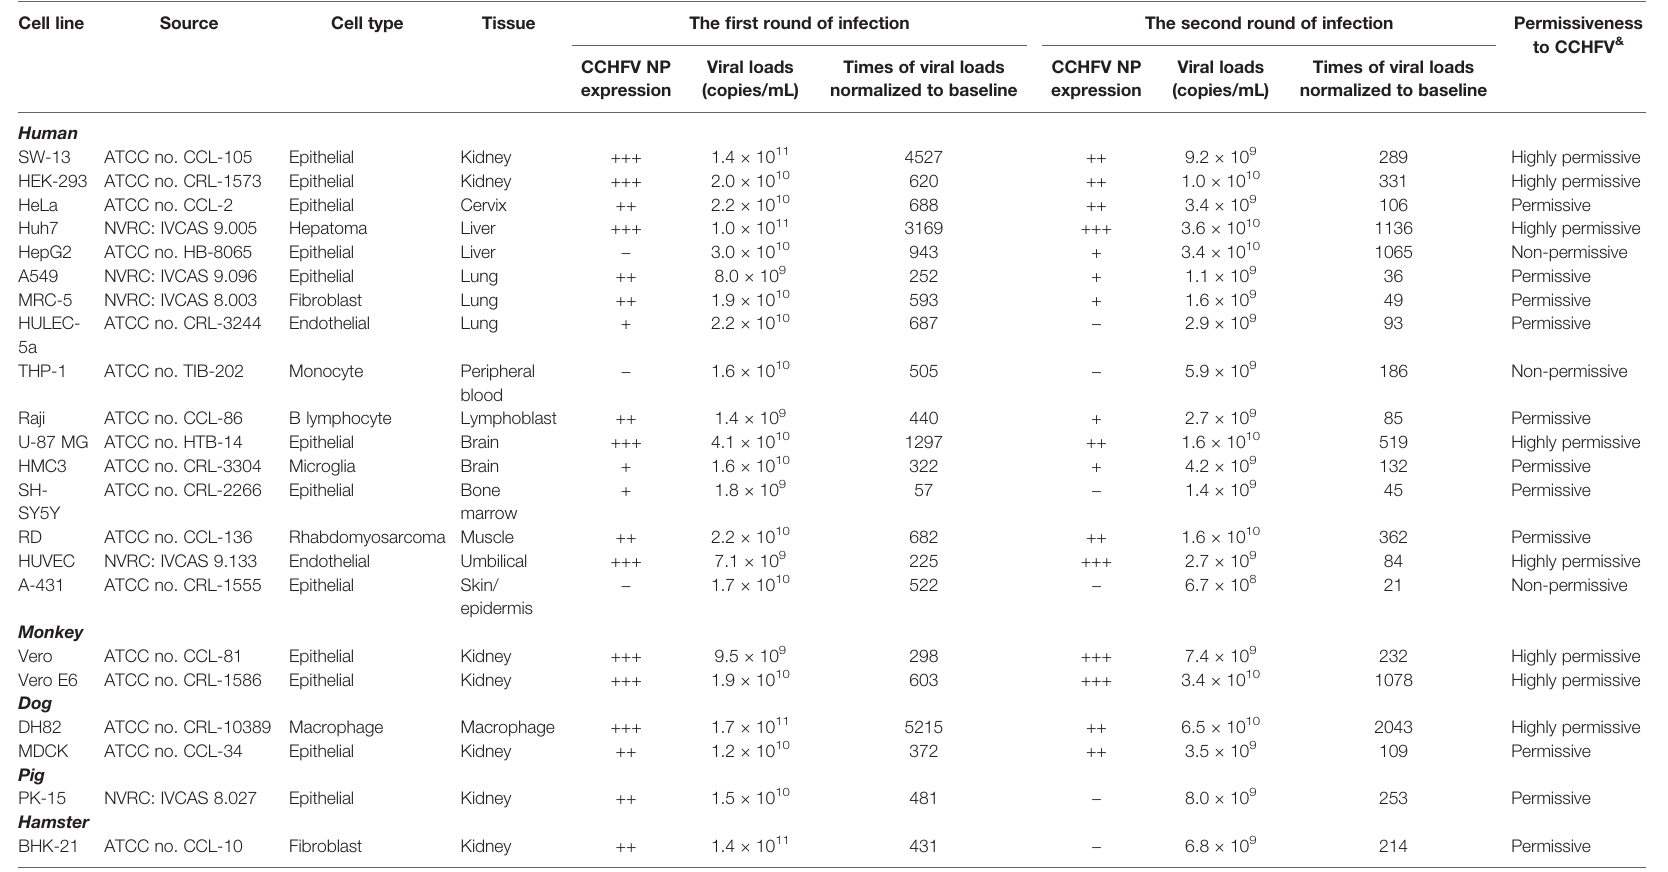
TABLE 1 | Cell lines tested for CCHFV infection